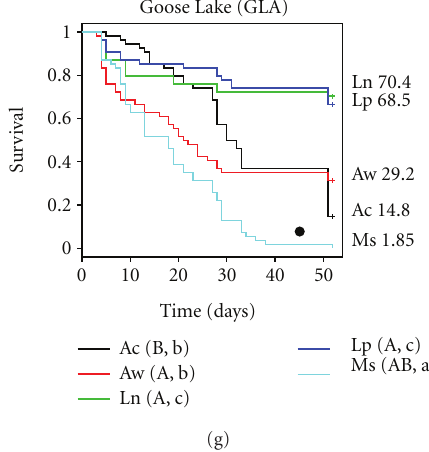
Figure 3: Survival curves for the seven populations studied. Colors indicate survival associated with a given plant; letters next to each plant in legends correspond to di ff erences in the shape (upper case) and scale (lower case) of each curve indicated by nonoverlapping 95% confidence intervals from bootstrapped parameter values (see Table 4 for more details). Black dots indicate native host association for each population. Average, final survival is shown to the right of each graph for nonzero results. Plant abbreviations as follows. Ac; Astragalus canadensis ; Aw; Astragalus whitneyi ; Ln; Lotus nevadensis ; Lp; Lupinus polyphyllus ; Ms; Medicago sativa